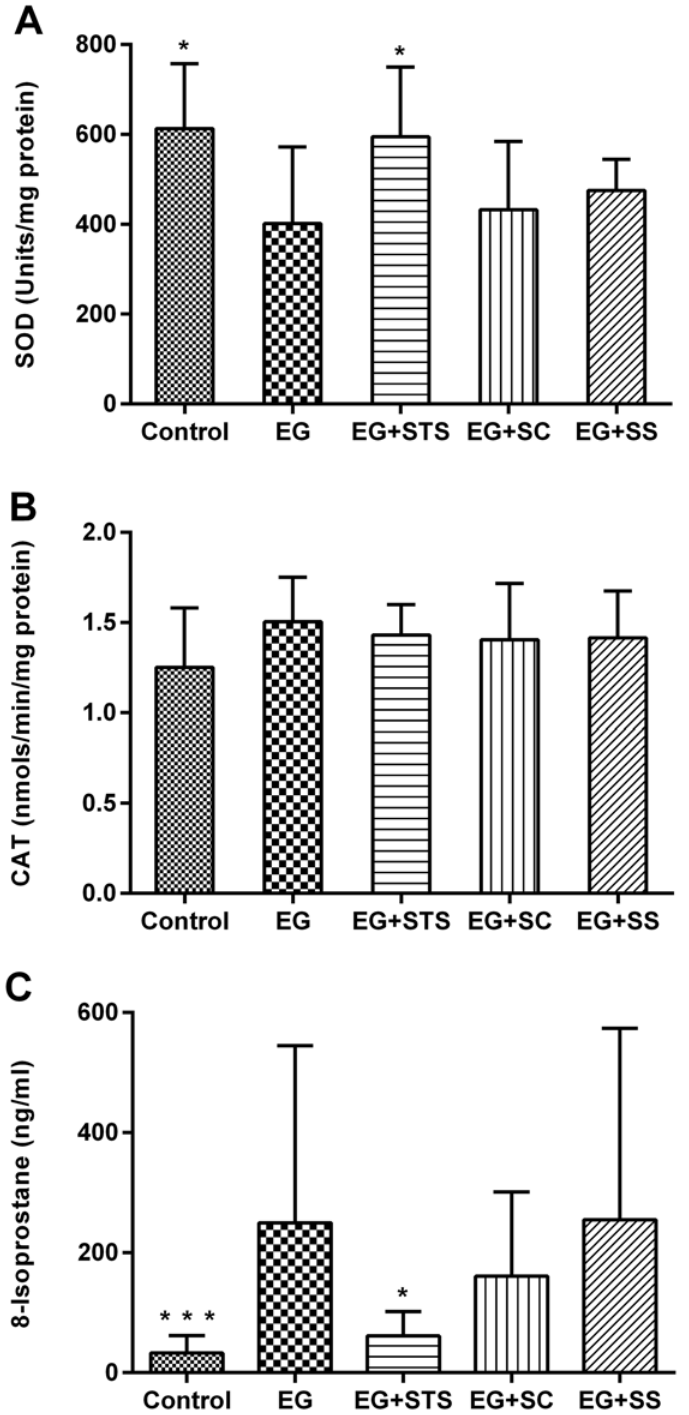
Fig 5. Oxidant-antioxidant status. The activities of the two antioxidant enzymes (A) Superoxide dismutase (SOD), and (B) Catalase (CAT) were determined in renal tissue at time point 4 weeks in the control, EG, EG+STS, EG+SC and EG+SS animal group. SOD activity was preserved with STS treatment; (C) Urinary 8-Isoprostaglandin levels were elevated in the EG-exposed animals and maintained in the normal range only in STS-treated animals. The changes and significance levels are with reference to the EG group. The data are means ± SD from 7 – 8 animals per group. * p < 0.05, ** p < 0.01, *** p < 0.001.